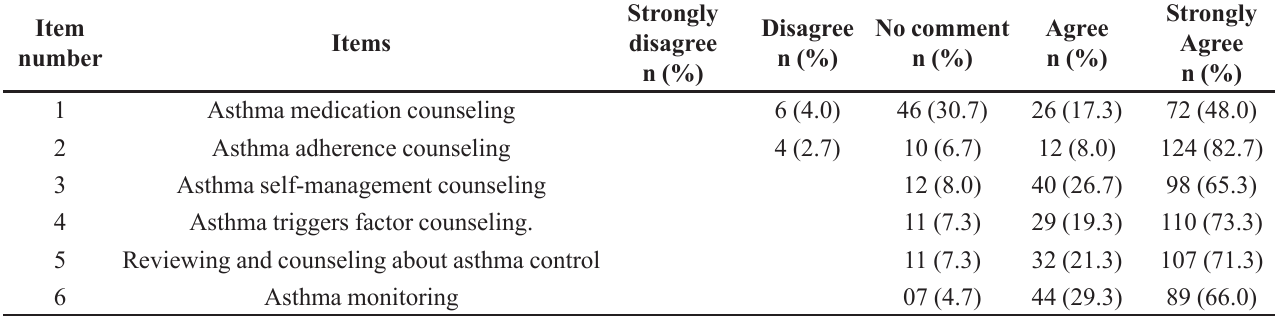
TABLE V - Lack of Confidence or